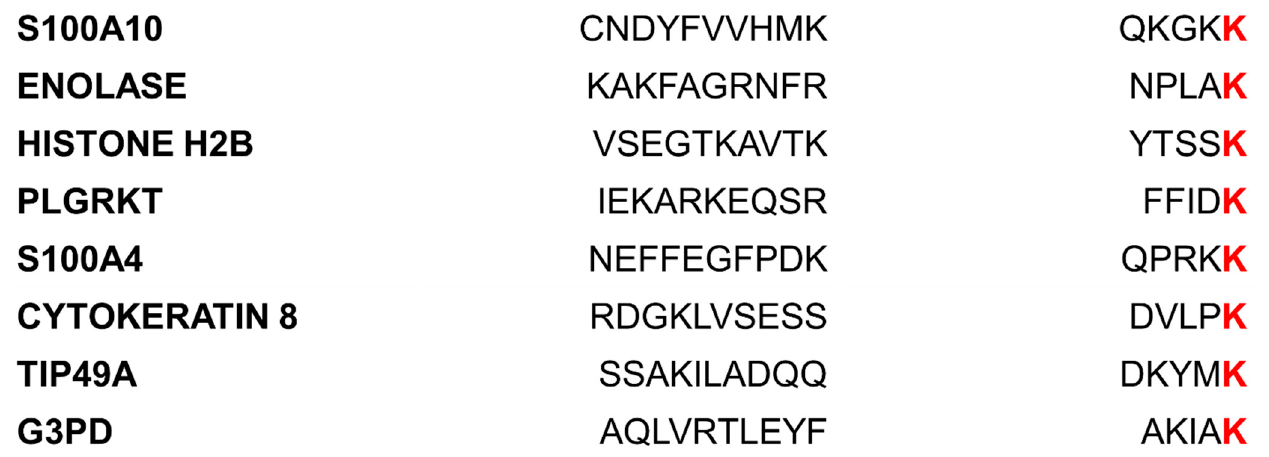
Figure 2. Comparison of carboxyl-terminal lysines of plasminogen receptors. This figure shows that there is no homology in the amino acid sequence of the carboxyl-terminal residues of eight well-characterized carboxyl-terminal lysine-type plasminogen receptors.